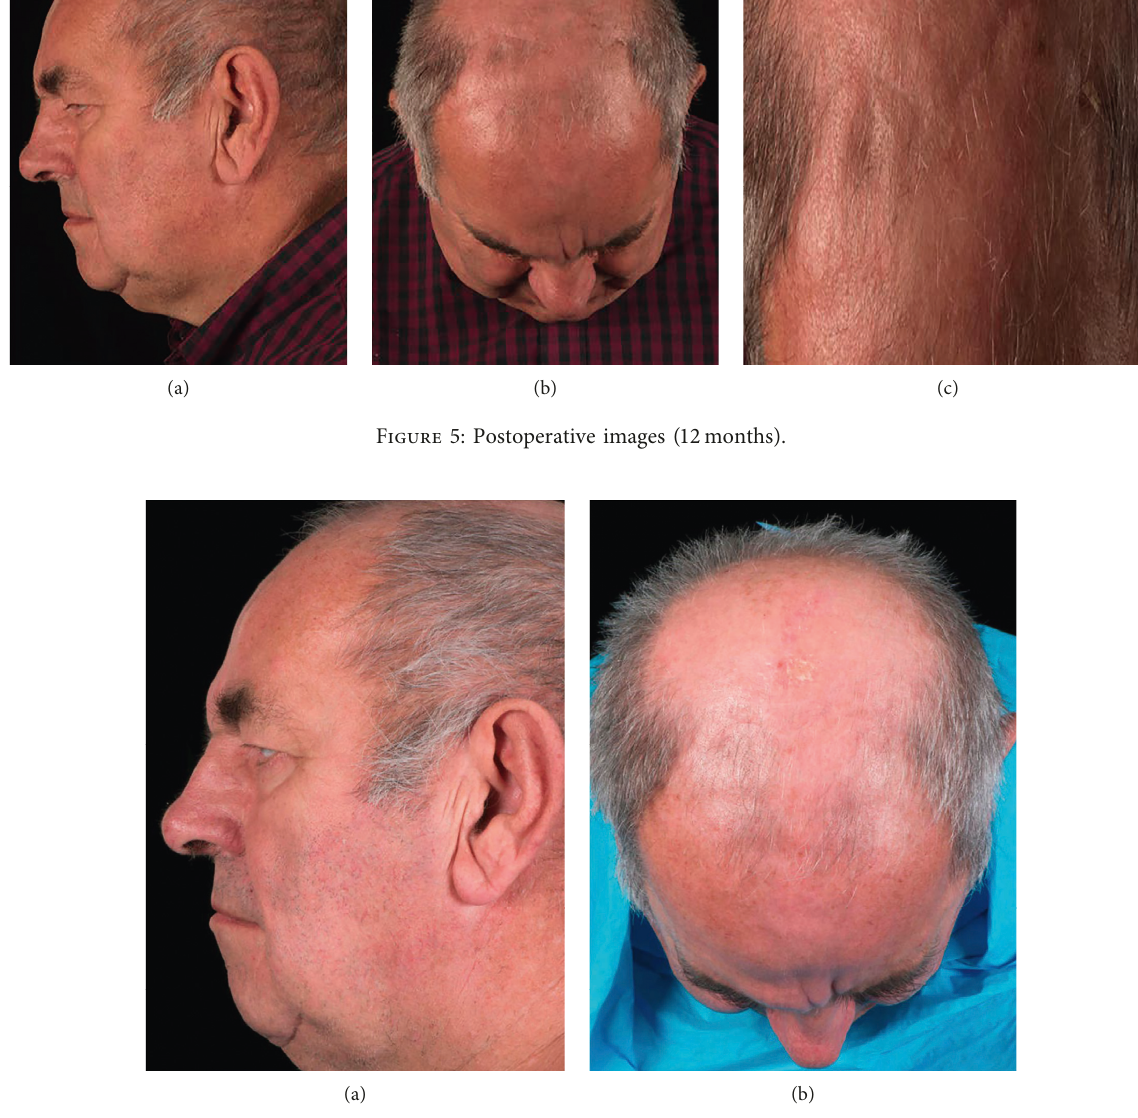
Figure 6: Postoperative images